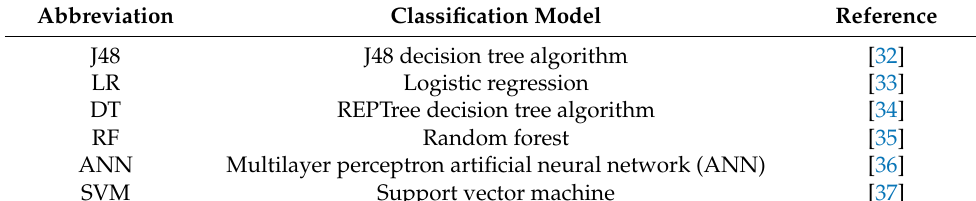
Table 2. List of machine learning models used in classification.